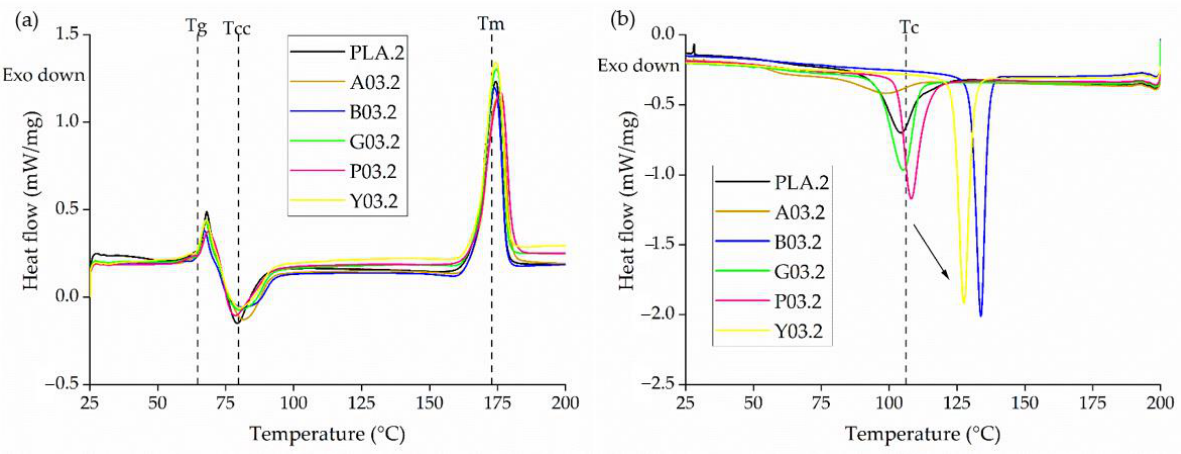
Figure A2. DSC thermograms of PLA and dyed yarns containing 0.3% ( w / w ) of each colorant at an SSD ratio of 2 during ( a ) the heating cycle and ( b ) the cooling cycle.